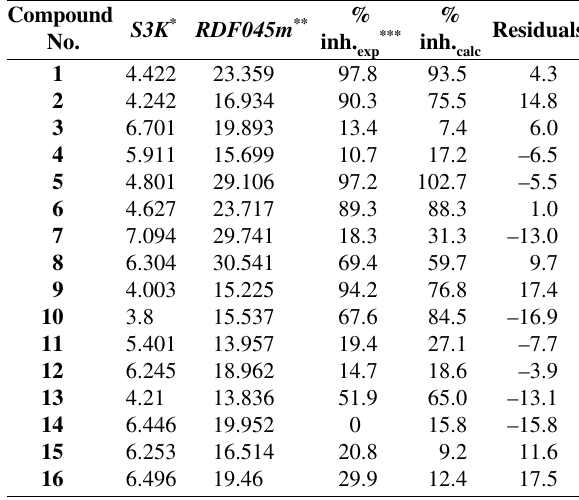
Table 1. Inhibitory activities of benzimidazole derivatives against human DPP III determined experimentally (% inh. ), the calcula- exp ted inhibitory activities (% inh. ) obtained using model III, the re- calc siduals, and the values of descriptors involved in the model. Compound S3K * RDF045m